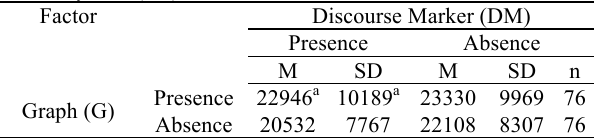
Table 1. Mean and Standard Deviation for Fixation Time on the verbal system (SV).